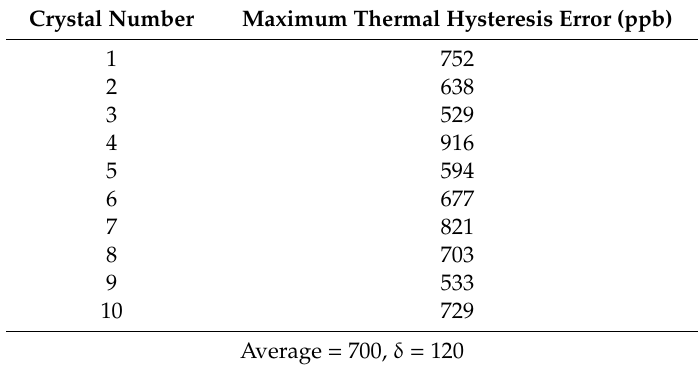
Table 1. Maximum thermal hysteresis error of each TCXO before thermal hysteresis